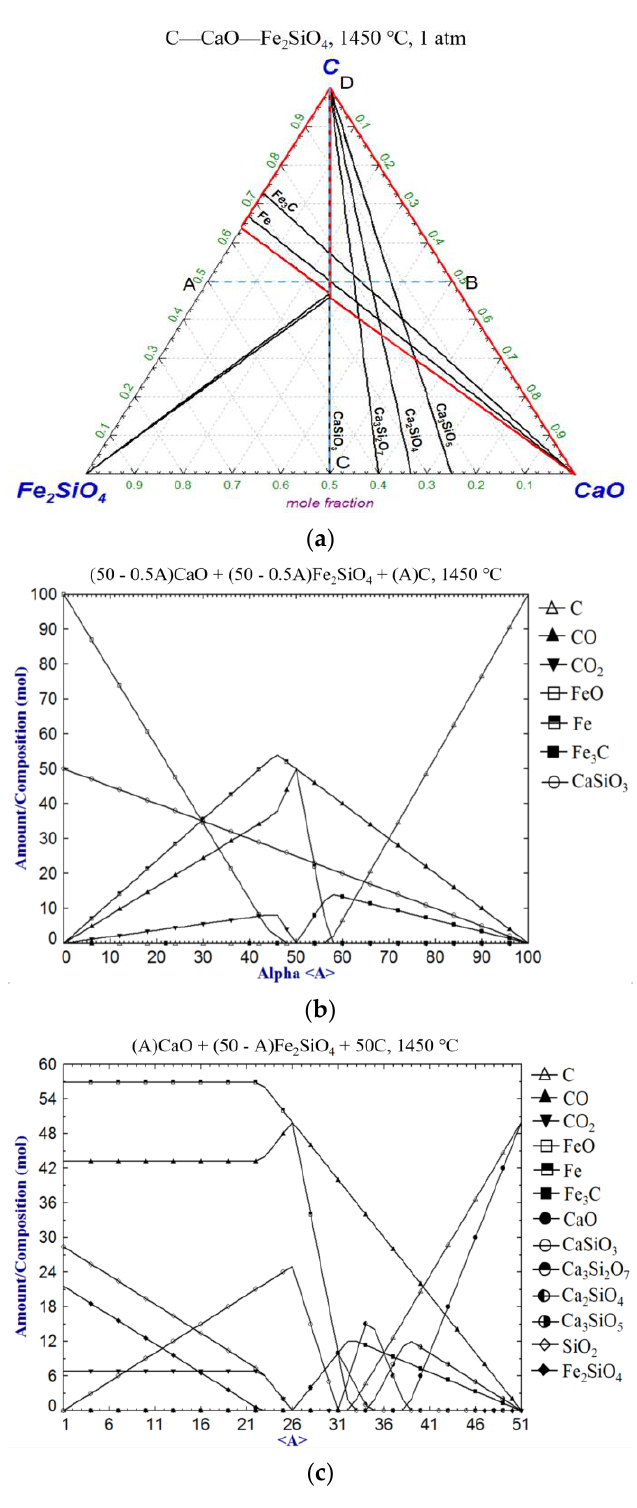
Figure 6. Phase diagram and equilibrium composition of iron oxide reduction. ( a ) C – CaO – Fe 2 SiO 4 ; ( b ) (50 − 0.5A)CaO + (50 − 0.5A)Fe 2 SiO 4 + (A)C; ( c ) (A)CaO + (50 − A)Fe 2 SiO 4 + 50C ( b ) (50 − 0.5A)CaO + (50 − 0.5A)Fe − A)Fe 2 SiO 4 + (A)C; ( c ) (A)CaO + (50 2 SiO 4 +